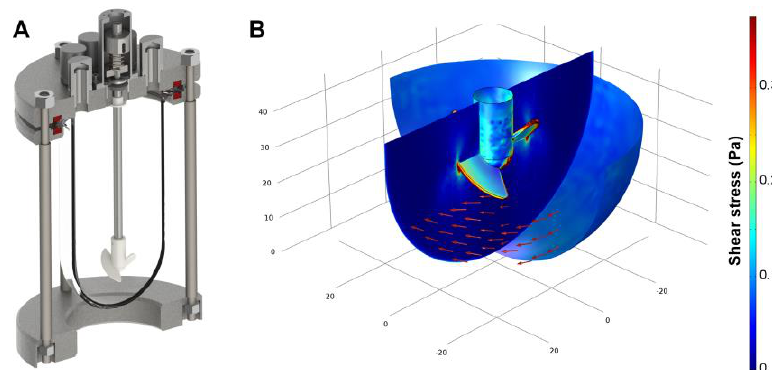
Figure 1. ( A ) Three-dimensional model of the stirred tank reactor used for aggregate cultivation; ( B ) Flow field direction (red arrows) and shear stress distribution (color legend) at a rotational speed of 600 rpm as estimated by computational fluid dynamics.